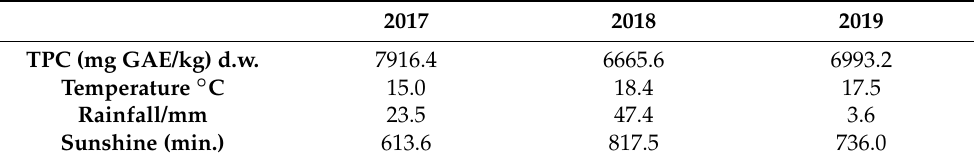
Table 2. Changes in temperature, precipitation and sun radiation during the monitored years 2017/2018/2019 in relation to the determined total contents of